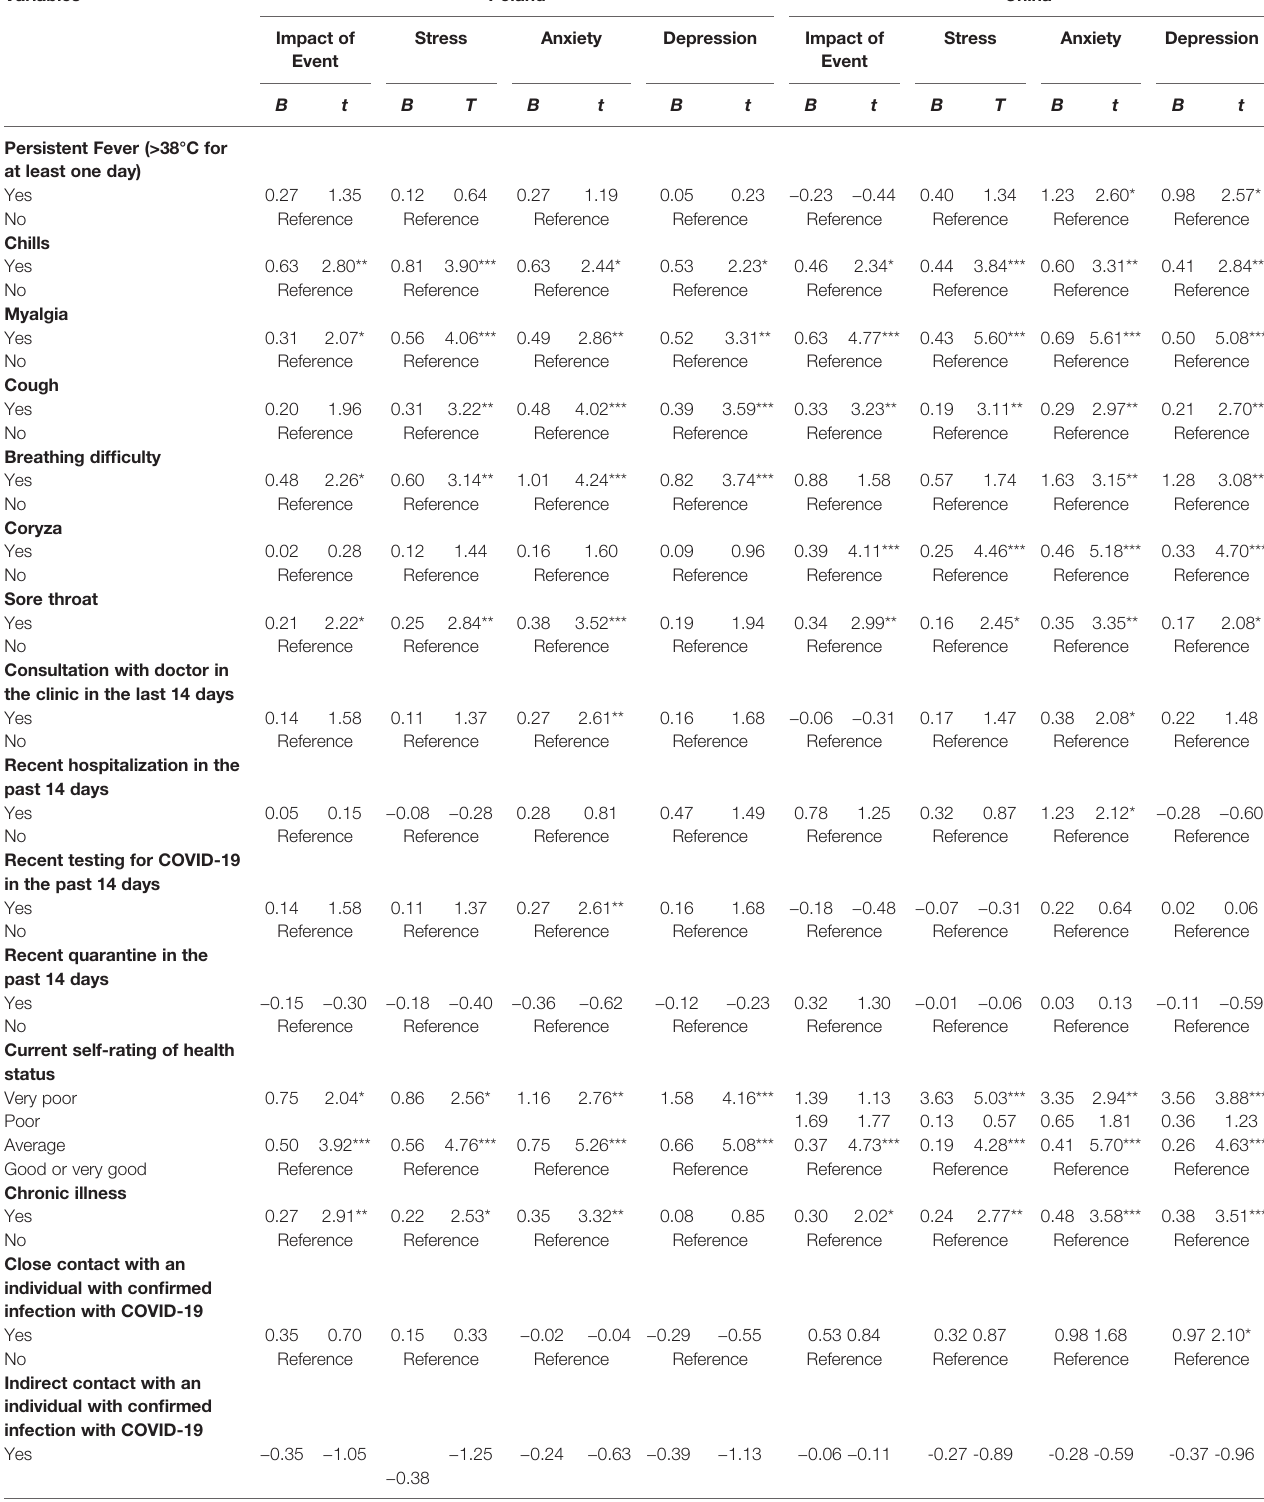
TABLE 4 | Association between physical health status in the past 14 days and contact history, and the psychological impact of 2019 coronavirus disease outbreak (COVID-19) as well as adverse mental health status between Polish and Chinese respondents during the epidemic with adjustment for age, gender, and education levels (N = 2266).